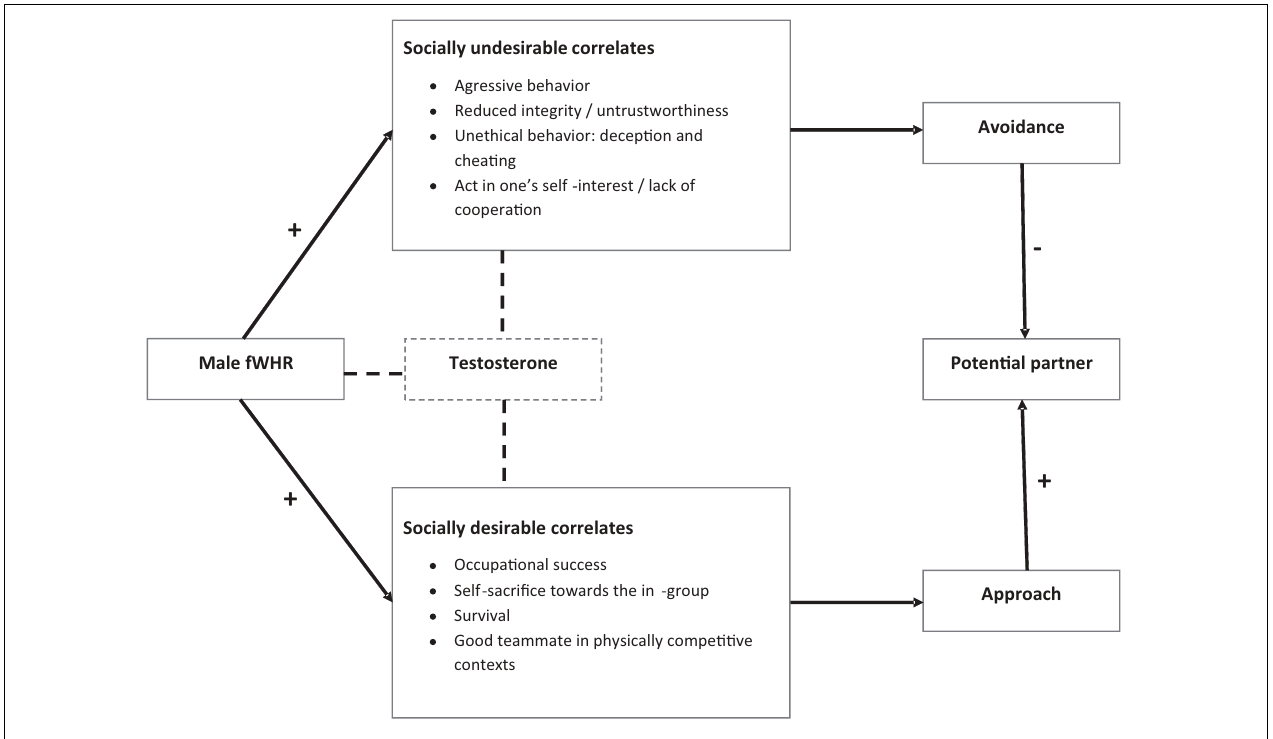
FIGURE 2 | Overview of the socially desirable and undesirable correlates of high-fWHR